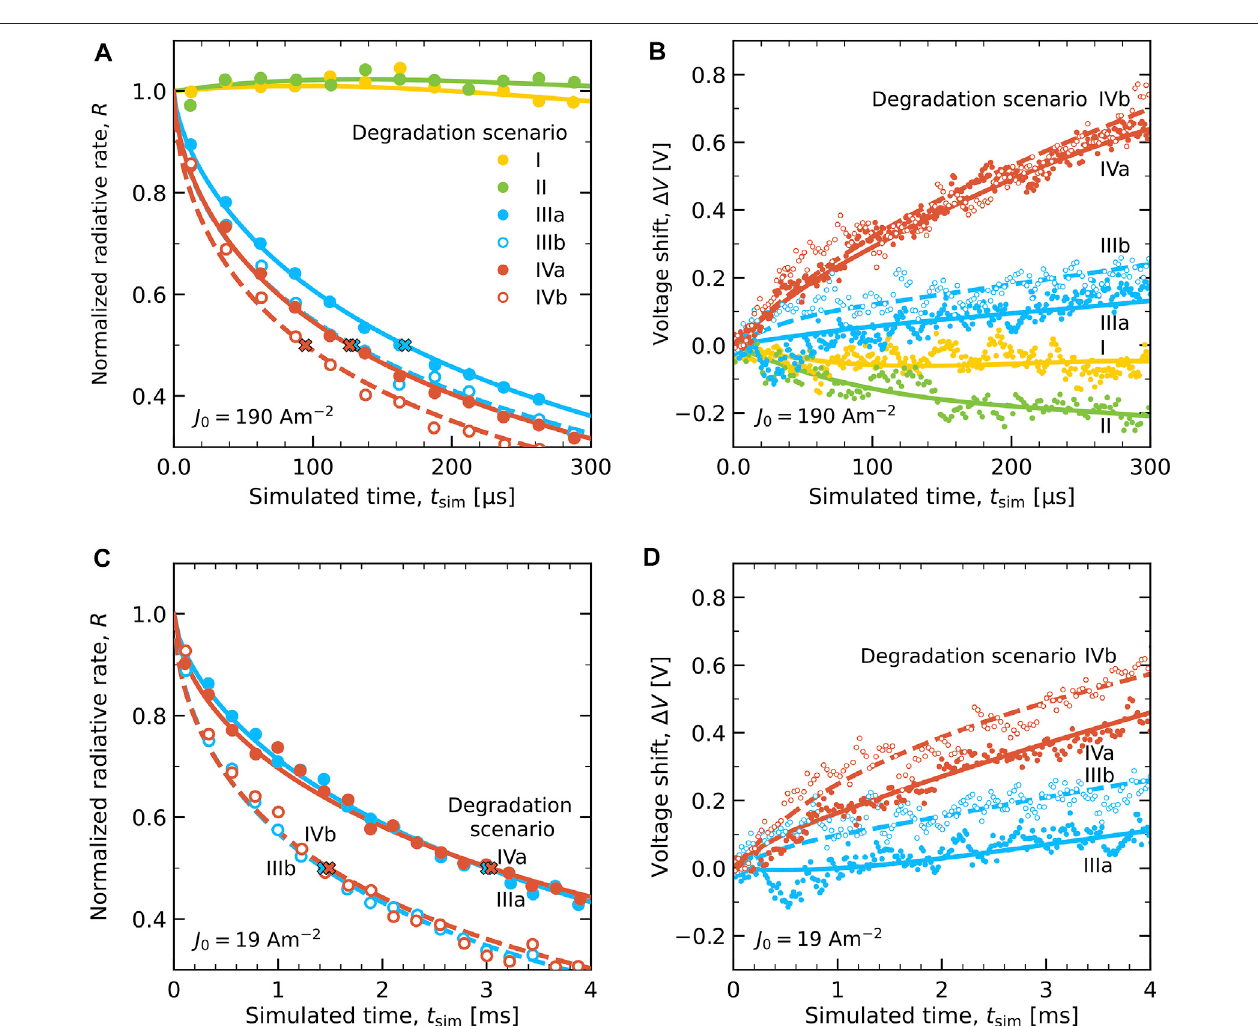
FIGURE7| Degradation simulationresults with fullsymbols forscenariosI, II,IIIa and IVa, and hollowsymbolsfor IIIband IVb. (A) The normalized radiative rate R ( t ) ofallsixscenariosat J 0 (cid:2) 190Am − 2 withcrossesmarkingtheLT50lifetimes, τ 50,sim .Thecurvesarestretchedexponential fi tsforscenariosIIIaandIVa(dashedcurvesfor IIIb and IVb). (B) The voltage shift Δ V of all six scenarios with respect to the equilibrated pristine state ( t (cid:2) 0) at J 0 (cid:2) 190 Am − 2 . (C) R ( t ) after rescaling to J 0 (cid:2) 19 Am − 2 by applyingthescenario-speci fi ccurrent-rescalingfactor α J (see Table2 )forscenariosIII(a,b)andIV(a,b). (D) Corresponding Δ V ofscenariosIII(a,b)andIV(a,b)at J 0 (cid:2) 19 Am − 2